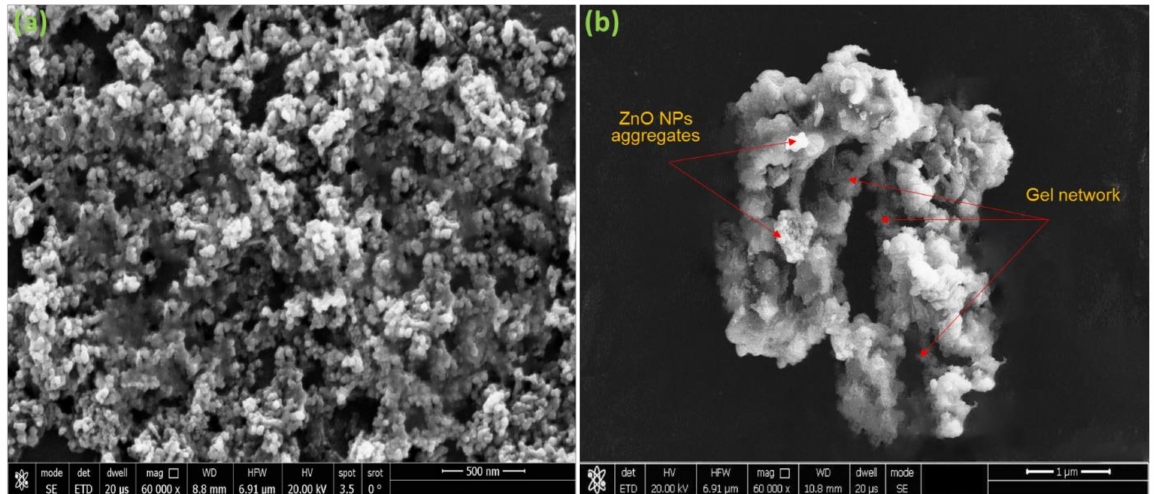
Figure 7. Field-Emission SEM image of ( a ) ZnO NPs and ( b ) Carbopol/ZnO hybrid nanoparticles gel.